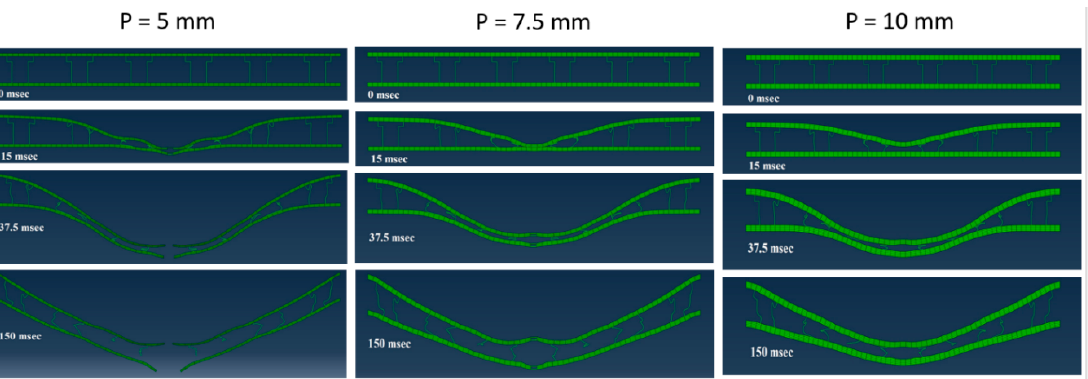
Figure 19. Damage development for mushroom shape with different façade plate thickness: 5 mm, 7.5 mm, and 10 mm with core–core spacing of 112.5 mm.